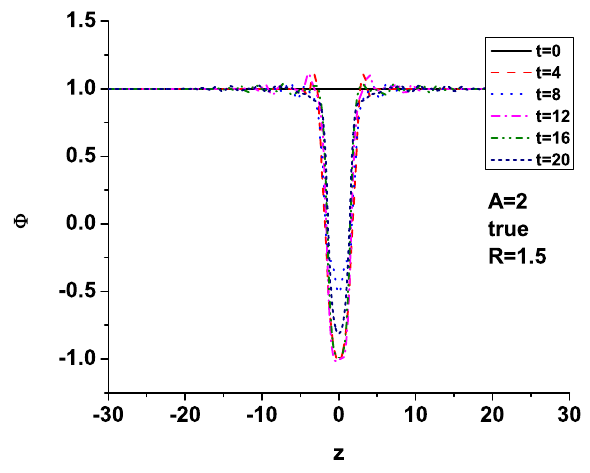
Figure 11 . Not all of the bubbles of the true vacuum are able to expand. If there is no enough energy to support the expansion of the bubble (e.g. if the strength of the interaction between the object and the field is low), the vacuum decay process cannot be completed. We set here initial v O = 0 , A = 2 , R = 1 . 5 , m = 10 10 , a = − 0 . 2 , r = 0 . Note that the value of the parameter A is much lower than in figure 10.